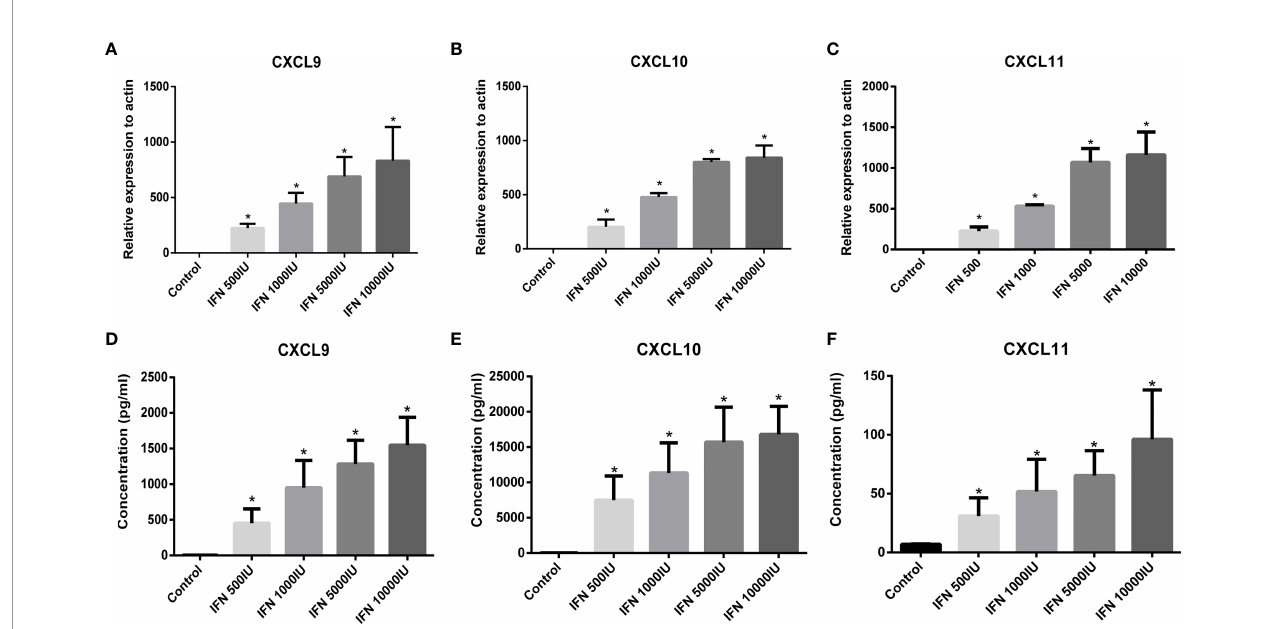
FIGURE 2 | Expression of CXCL9 (A) , CXCL10 (B) , and CXCL11 (C) in primary granulosa cells stimulated by IFN g (IFN-g) was detected by RT-PCR. Expression of CXCL9/10/11 in granulosa cells was absent under basal conditions (control) and was signi fi cantly stimulated by increasing doses of IFN g (ANOVA, P < 0.05). Bars represent the mean ± SEM. *P < 0.05 vs control by the Bonferroni-Dunn test. Concentration of CXCL9 (D) , CXCL10 (E) , and CXCL11 (F) in the culture supernatant from granulosa cells stimulated by IFN g . The release of CXCL9/10/11 from granulosa cells was absent under basal conditions (control) and was signi fi cantly stimulated by increasing doses of IFN g (ANOVA, P <0.05). Bars represent the mean ± SEM. *P < 0.05 vs control by the Bonferroni-Dunn test.